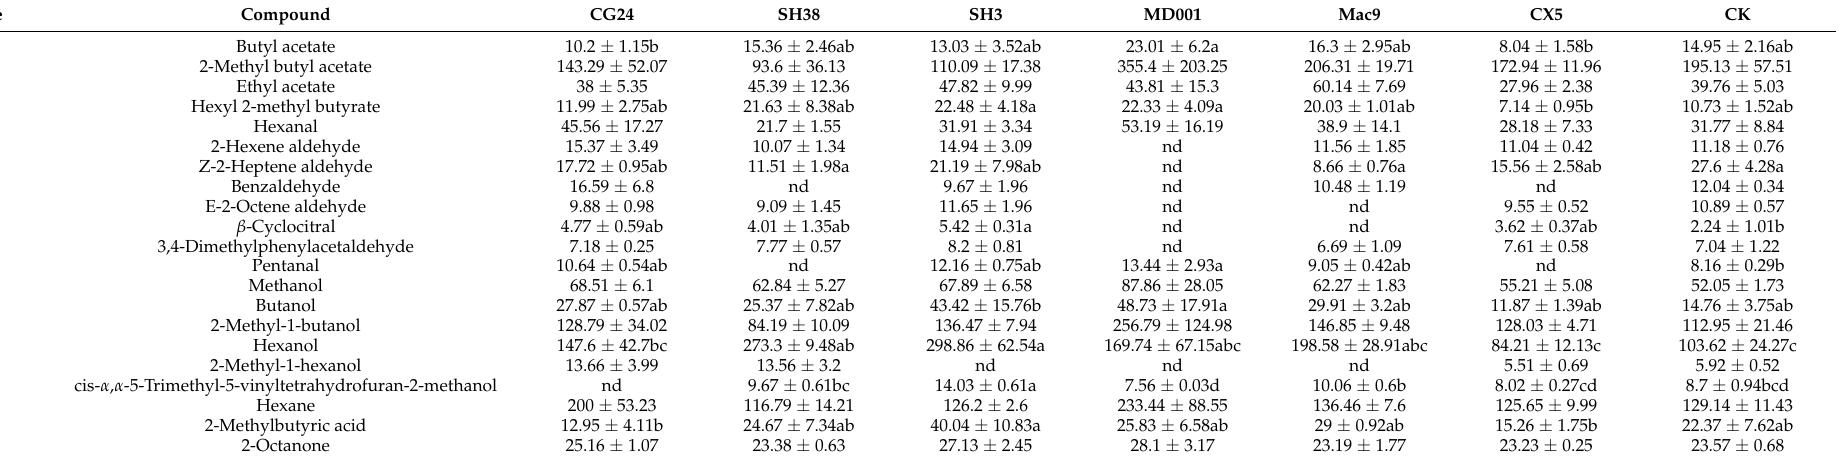
Table 3. Average content and standard error (mean ± SE; n = 3) of VOCs in pulp of ‘Huahong’ apples ( µ g/kg) grown from different dwarf interstocks (CG24, SH38, SH3, MD001, Mac9, CX5) as determined by